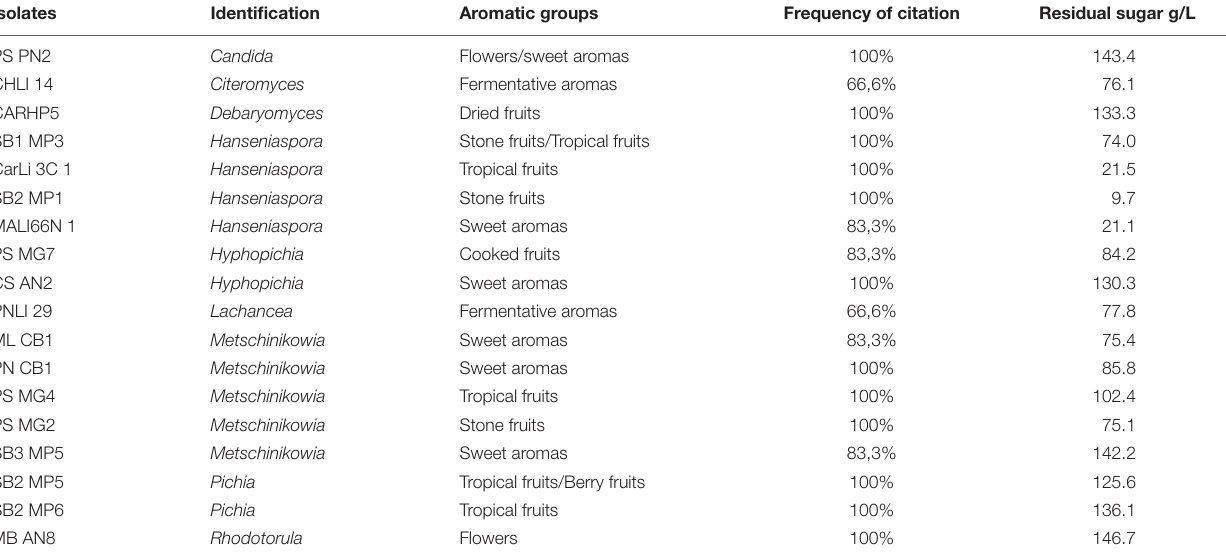
TABLE 4 | Sensory description evalutaion and residual sugar from select